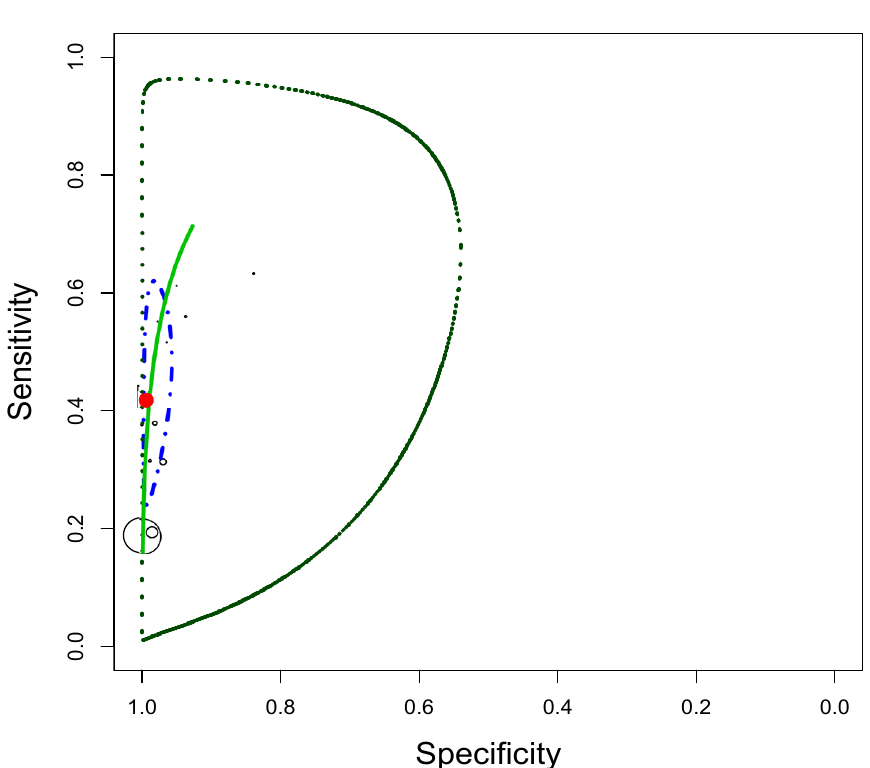
Figure 3. Summary receiver operating characteristic (SROC) for AuditC data. The dots represent the sensitivities and specificities found in the included studies. The line green represents the estimated SROC curve. The dashed line around it represents the 95% confidence interval of the estimated SROC curve. The red circle represents the estimated pooled sensitivity and specificity, and the blue ellipse represents its 95% confidence interval.